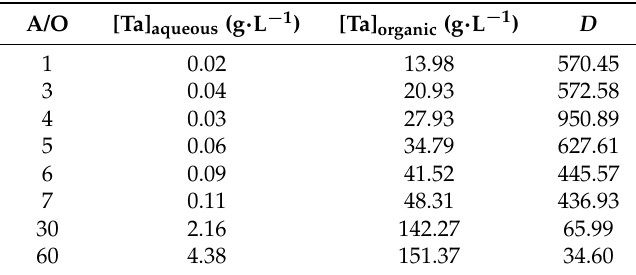
Table 3. Tantalum concentration in aqueous and organic phases and the distribution coefficient ( D ) at equilibrium as a function of various phase ratios (A/O).